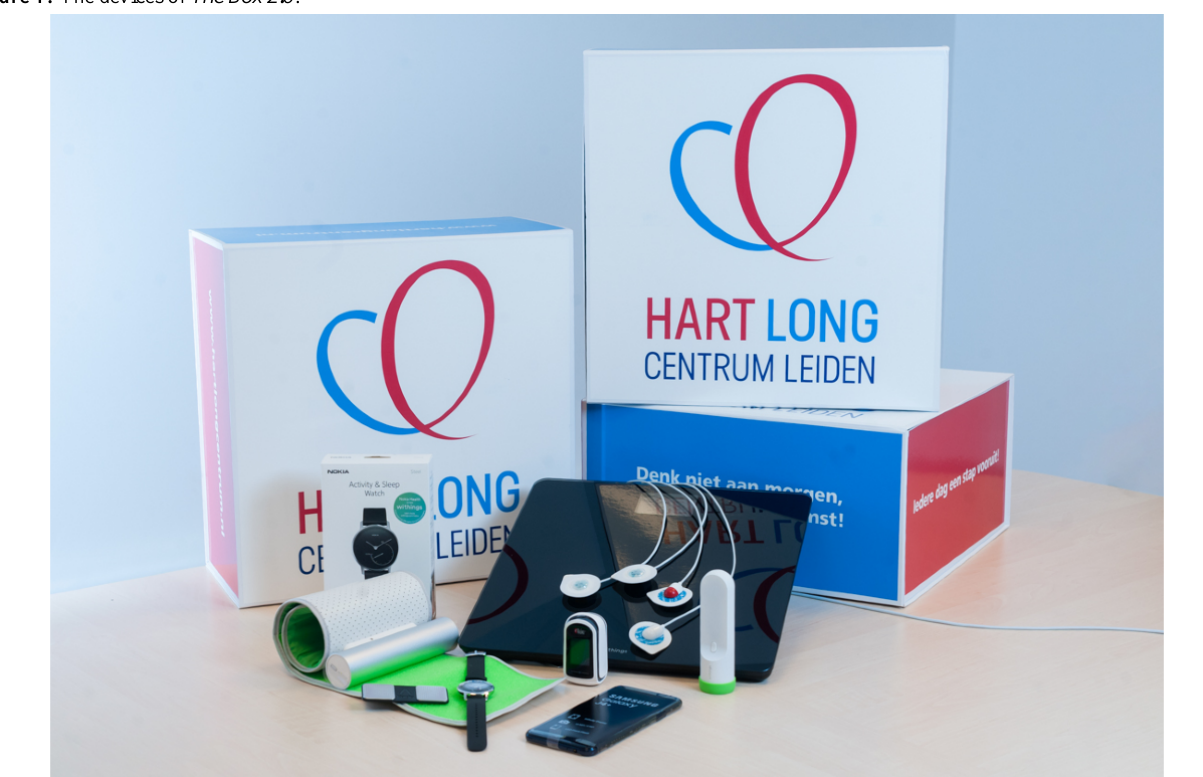
Figure 1. The devices of The Box 2.0